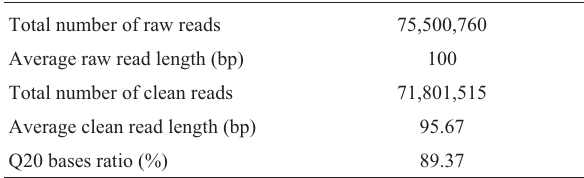
Table 1 - Output statistics for the L. dispar transcriptome sequencing pro- cess.